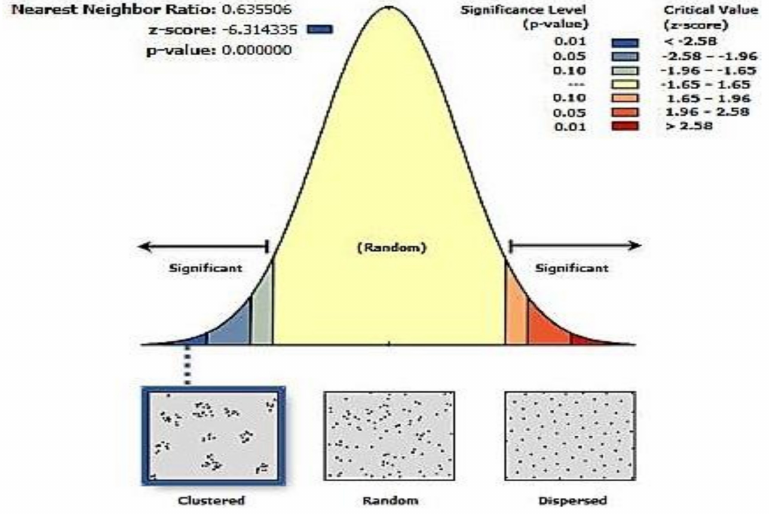
Figure 2. Average nearest neighbor